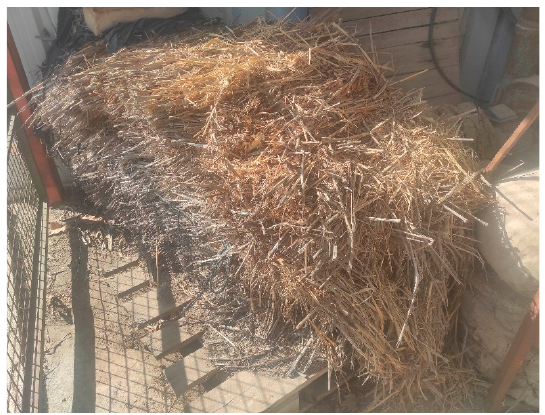
Figure 1. Sorghum waste used for manufacturing the experimental boards.